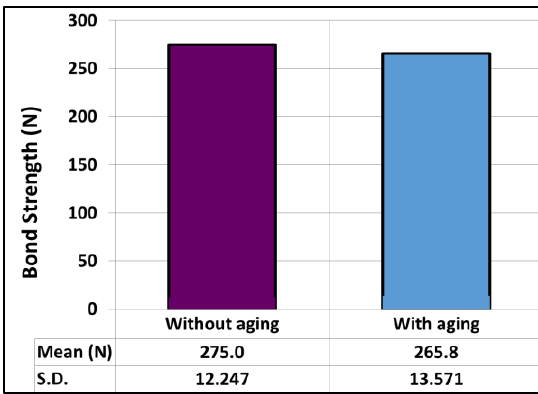
Figure 2 : Bond strength of PEEK retainer with and without